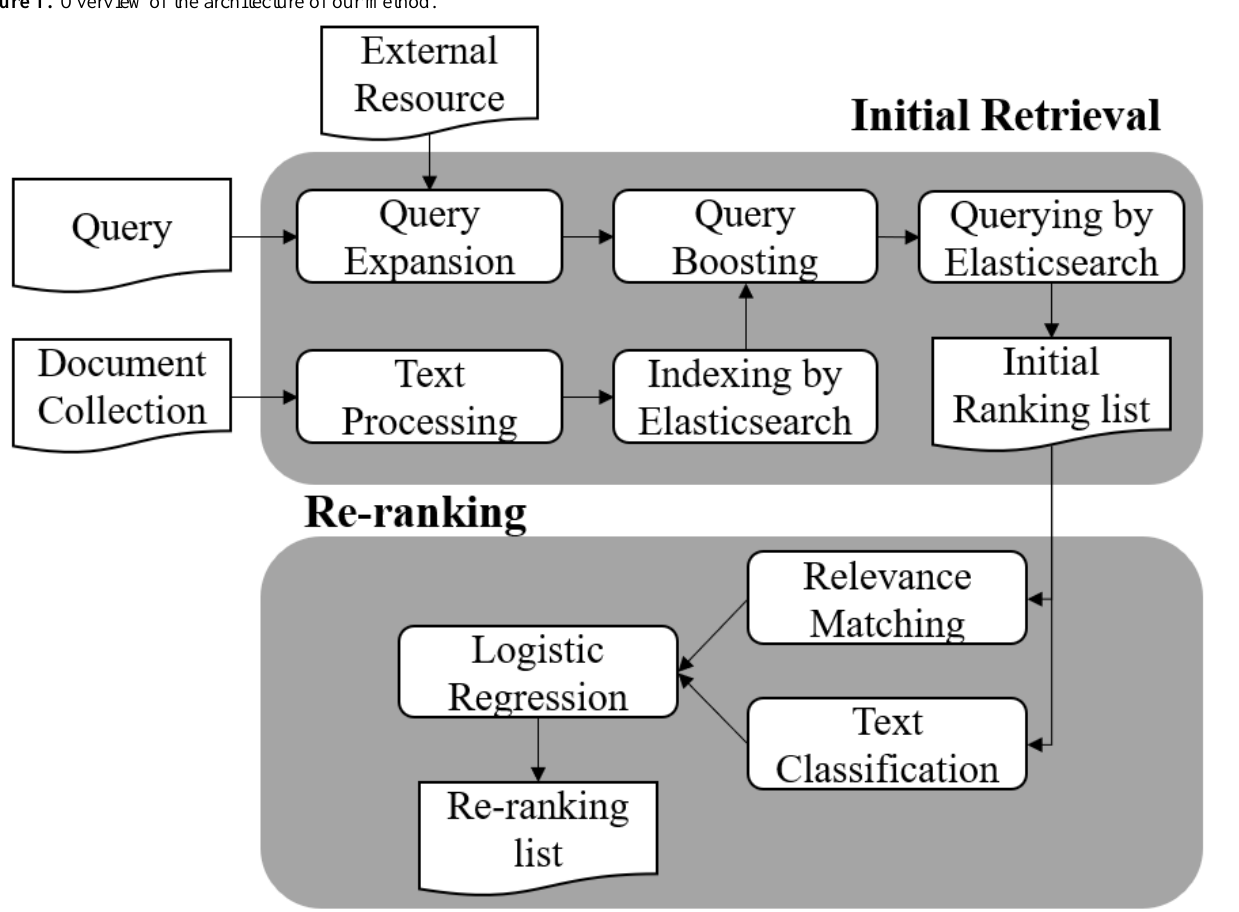
Figure 1. Overview of the architecture of our